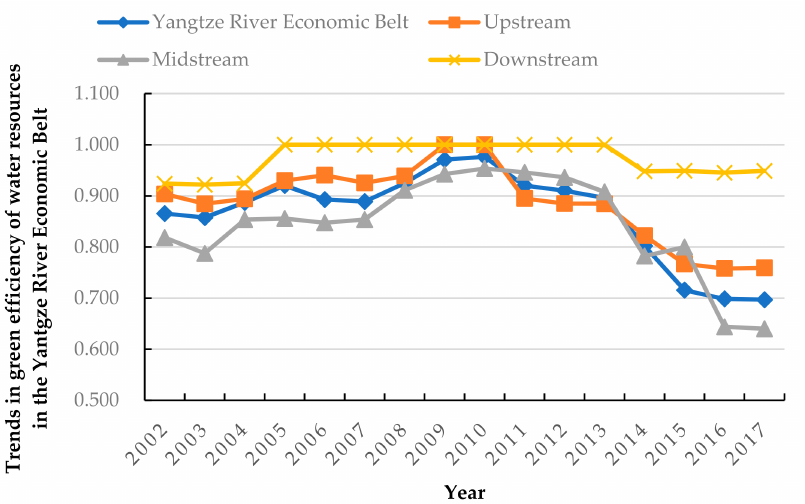
Figure 2. Trends in green efficiency of water resources in the Yangtze River Economic Belt, and its upstream, midstream, and downstream regions from 2002–2017.